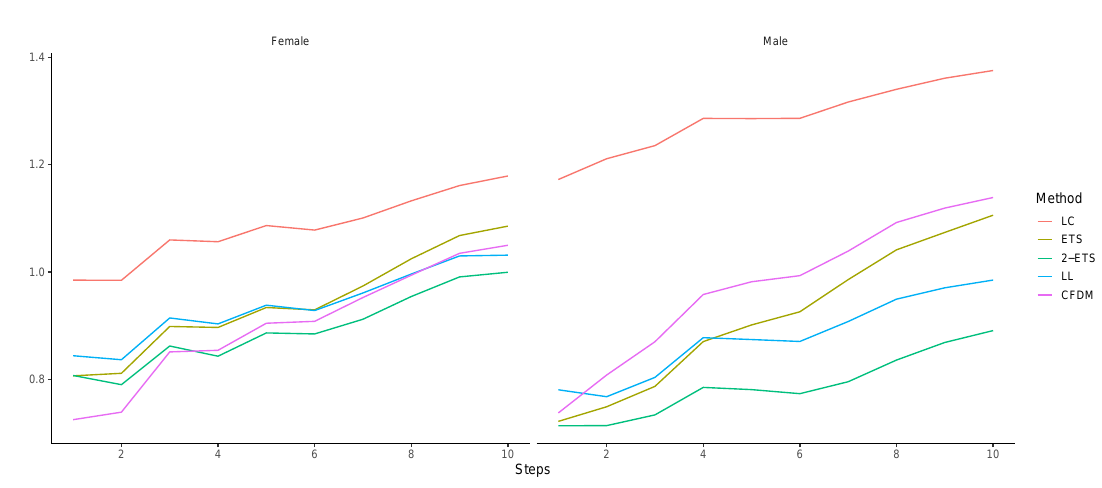
Figure 5. RMSE all , h , i plotted against forecasting horizon h for Australian mortality data. Table 2. Summary of RMSE h , i under different forecasting horizons for Australian mortality